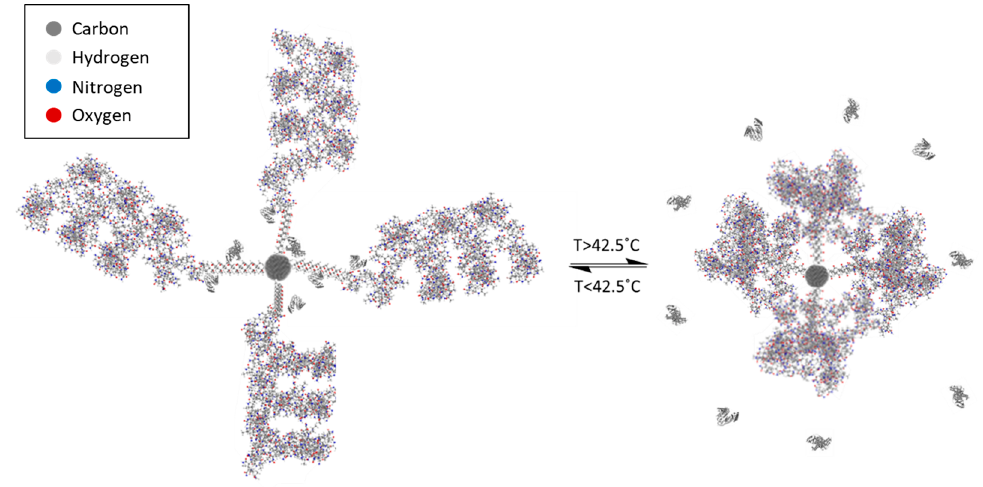
Figure 3. Release mechanism of the NCC upon radio wave stimulation. Schematic diagram illus- trating the physiological mechanism of protein-bearing drug release from the NCC upon reaching the LCST. A visualization of the activation of the complex upon heating and the collapse of grafted polymer chains.